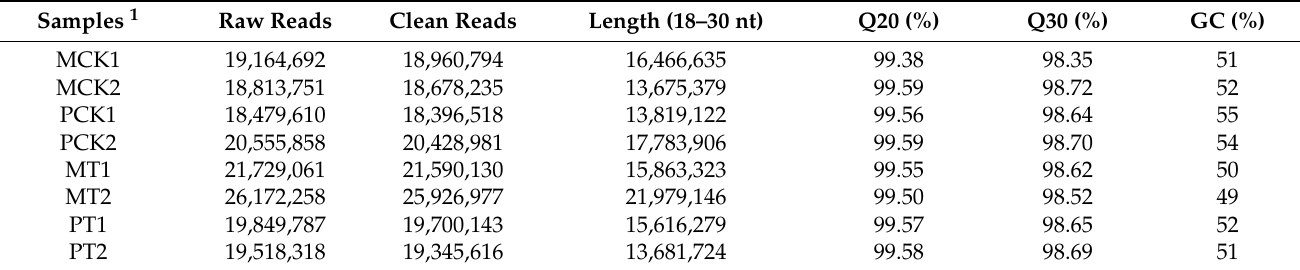
Table 1. Statistical analysis of small RNA sequencing data for eight